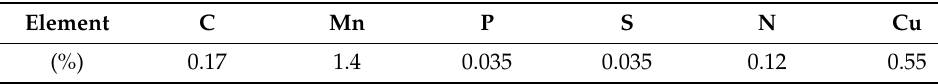
Table 1. Chemical composition of S235JR steel [6].